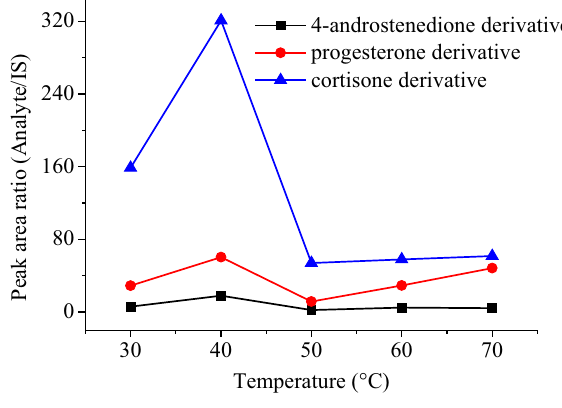
Fig. 4 Derivative efficiencies of different reaction temperatures for the representative steroids in human serum at reaction time of 20